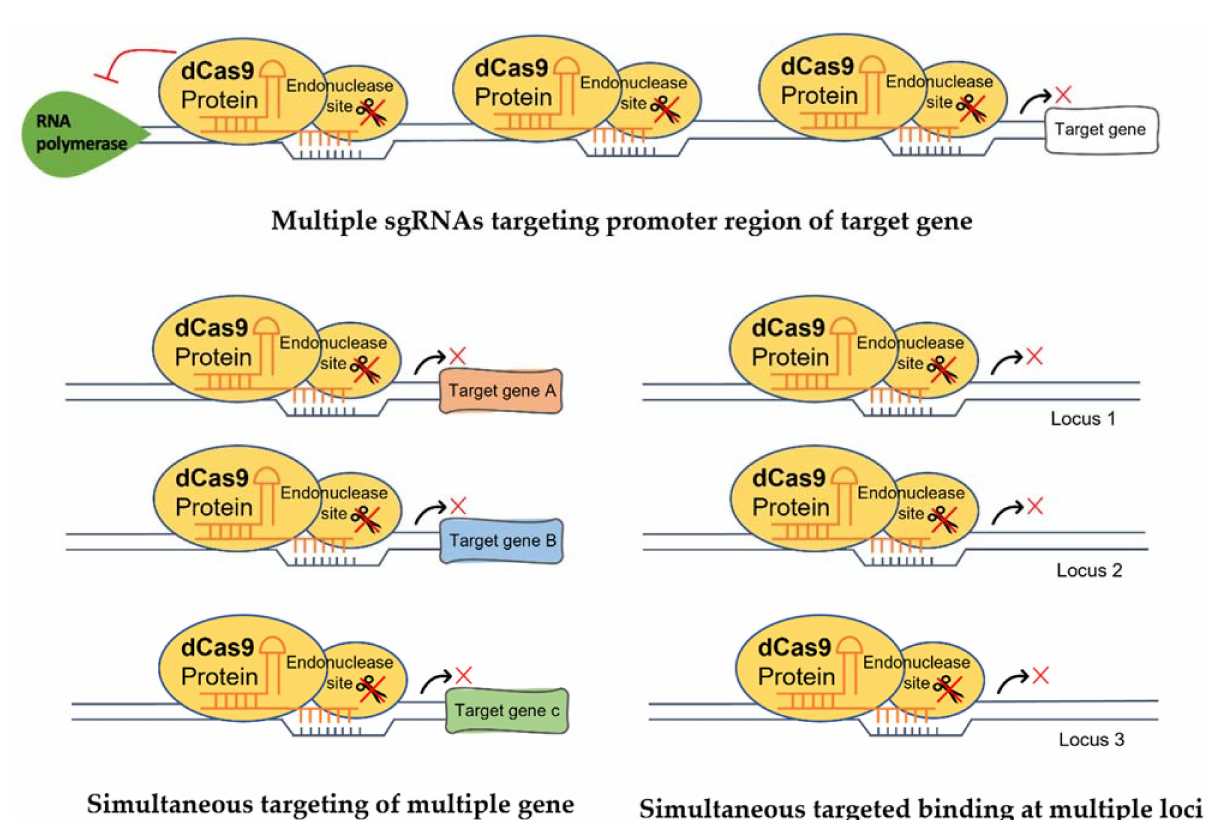
Figure 3. A schematic diagram shows the multiplexability of the CRISPR/dCas9 system. Enhancement of transcriptional regulation, simultaneous targeting of different genes and simultaneous targeted binding at multiple loci are possible using multiple sgRNAs.